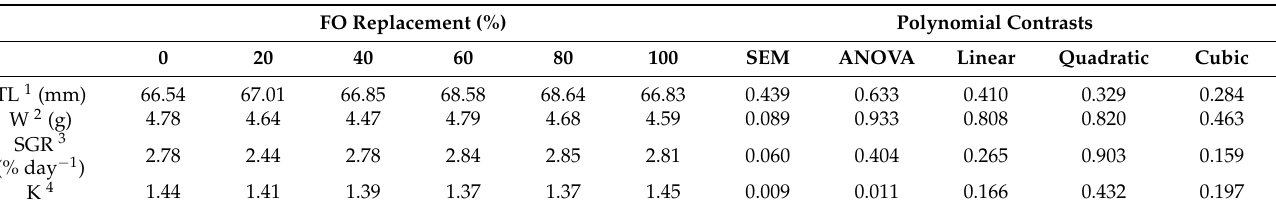
Table 5. Growth performance of juvenile tench fed practical diets with different replacements of cod liver oil (FO) with camelina oil (CO) over 90